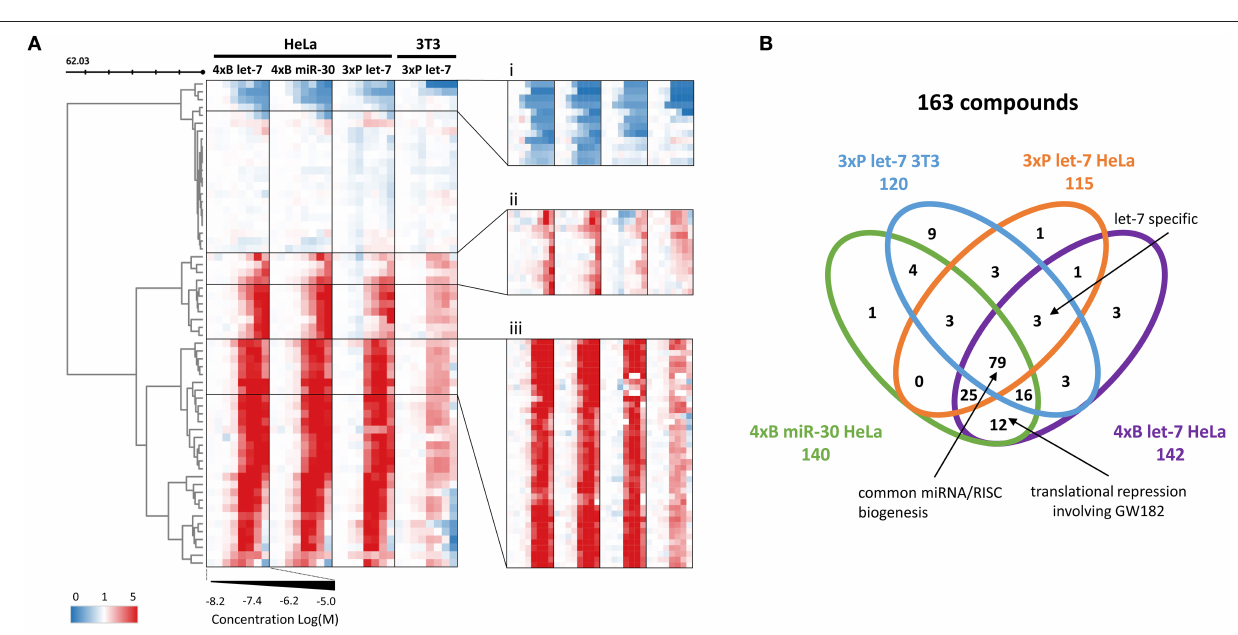
( Figure 3B ), almost half (79/163) of the compounds showed activity in all four reporter assays, and 120/163 in at least three of them ( Figure 4B ). In contrast, the above-mentioned 6-hydroxy-DL-DOPA showed some inhibitory dose-response effect only on the 4xB let-7 reporter in 3T3 cells.